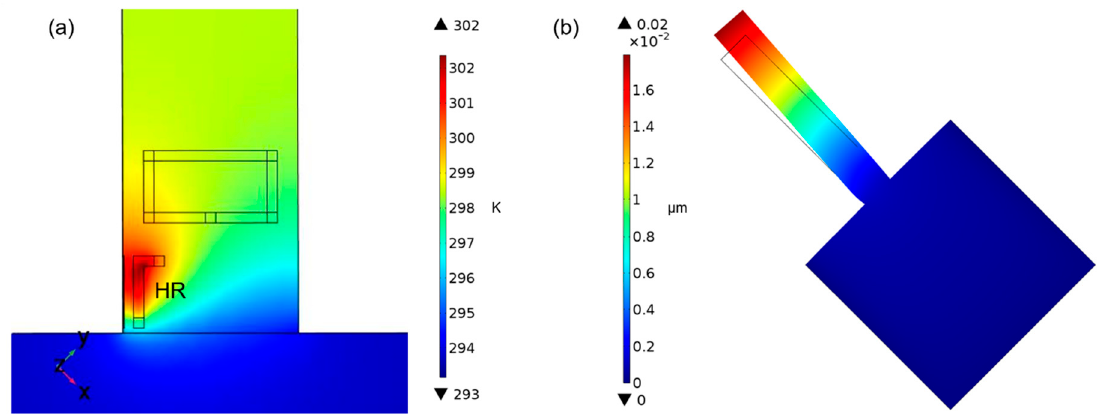
Figure 4. Finite element modelling (FEM) simulations of ( a ) a heating resistor (HR) with resistance of 1000 Ω ( p -silicon; lightly doped; specific heat capacity ( C p ) = 700 J/(kg·K); coefficient of thermal expansion ( α ) = 2.6 × 10 − 6 K − 1 ) and ( b ) beam deflection due to induced thermal-strain.